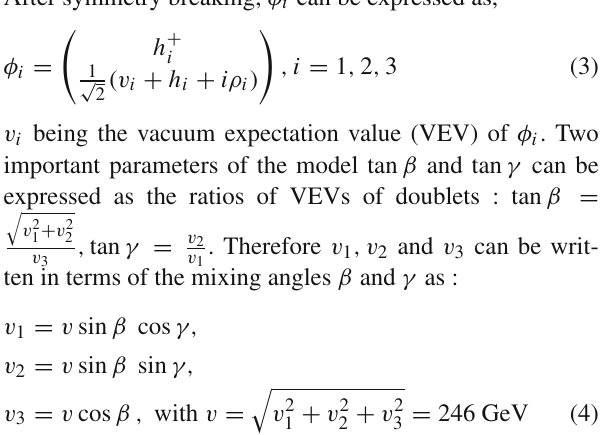
vs. M plane for α 3 = H + 1 1